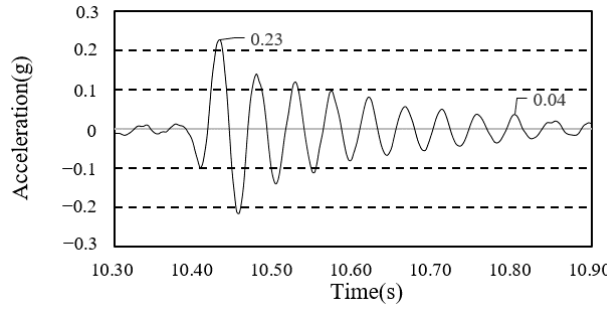
Figure 10. Power spectrum (framing completion).